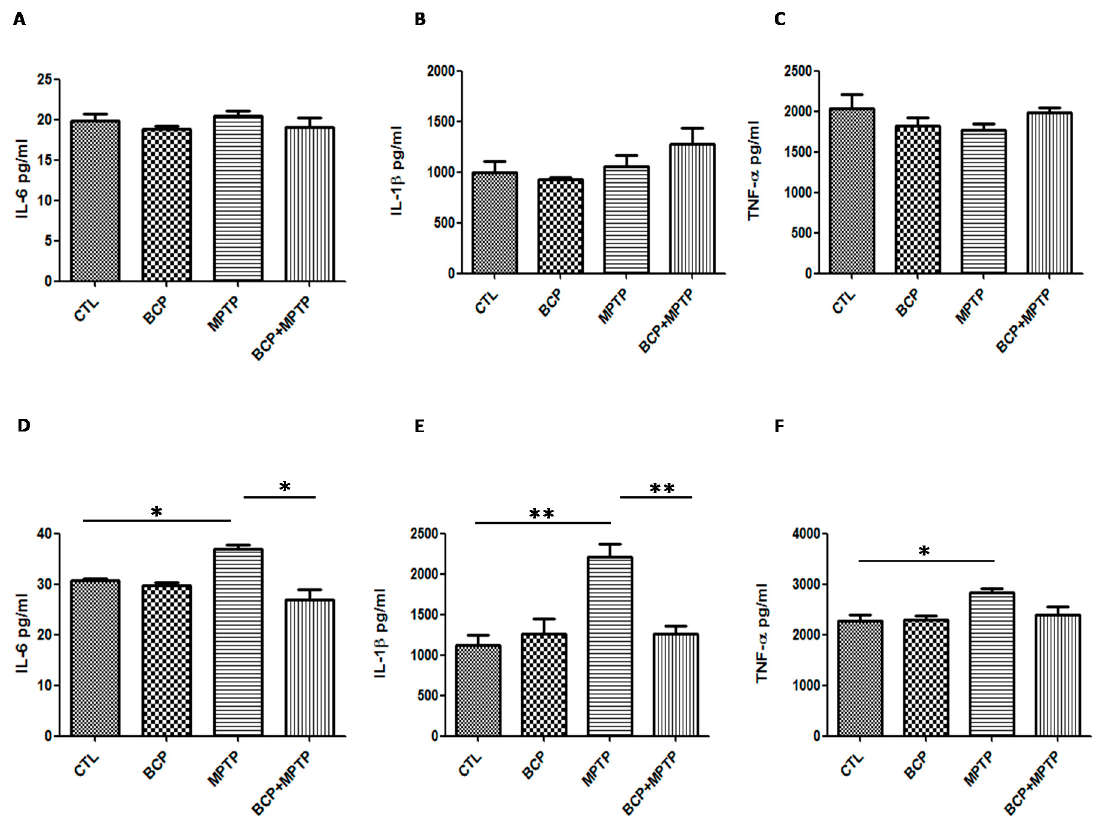
Figure 10. Protein levels of inflammatory cytokines in the nigrostriatal system. Graphsshowing the mean ± SEM of three individual experiments of the protein levels of IL-6, IL-1 β , andTNF- α in the striatum ( A – C ) and the substantia nigra ( D – F ) determined using the indirect ELISA method. IL-6 : * p < 0.05, CTL vs. MPTP treatment. * p < 0.05, MPTP treatment vs. BCP + MPTP treatment. IL-1 β : ** p < 0.01, CTL vs. MPTP treatment. ** p < 0.01, MPTP treatment vs. BCP + MPTP treatment. TNF- α : * p <